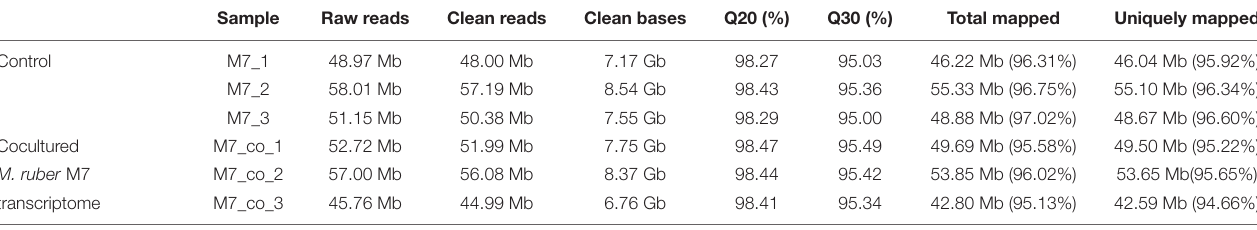
TABLE 3 | RNA-Seq clean reads and the counts, percentage of reads mapping statistics to Monascus purpureus genome. Sample Raw reads Clean reads Clean bases Q20 (%) Q30 (%) Total mapped Uniquely mapped